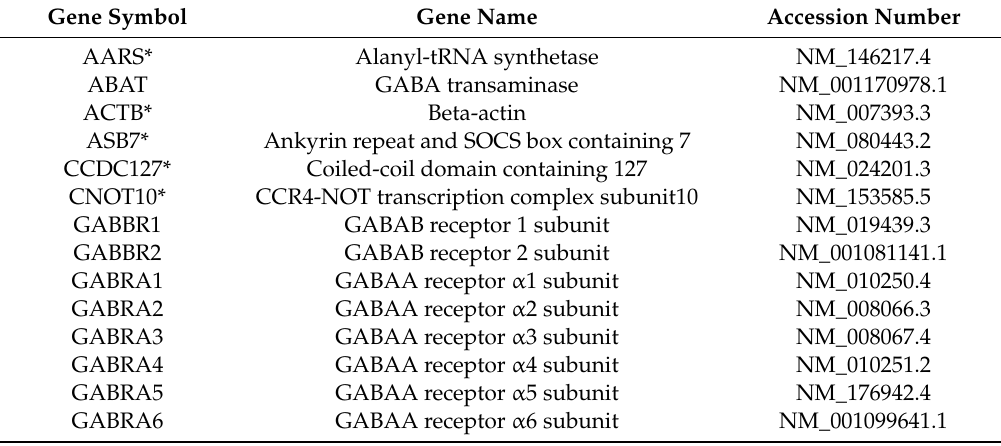
Table 2. List of genes encoding various components of the GABAergic system selected for RNA expression analysis using the NanoString nCounter system. Housekeeping genes are indicated with an